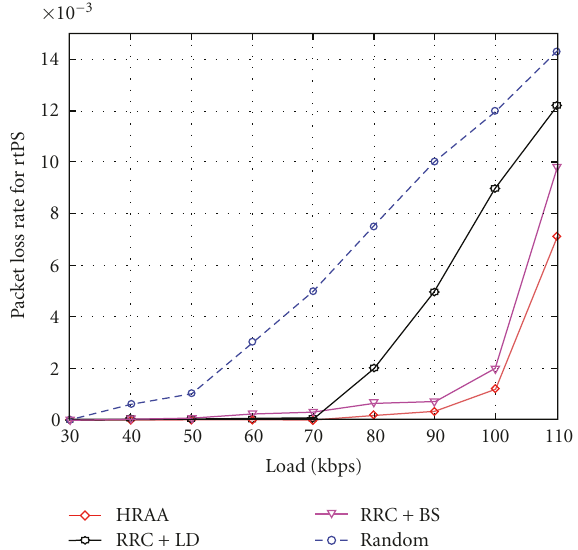
Figure 9: PLR comparison of rtPS SFs in outer ring cell versus